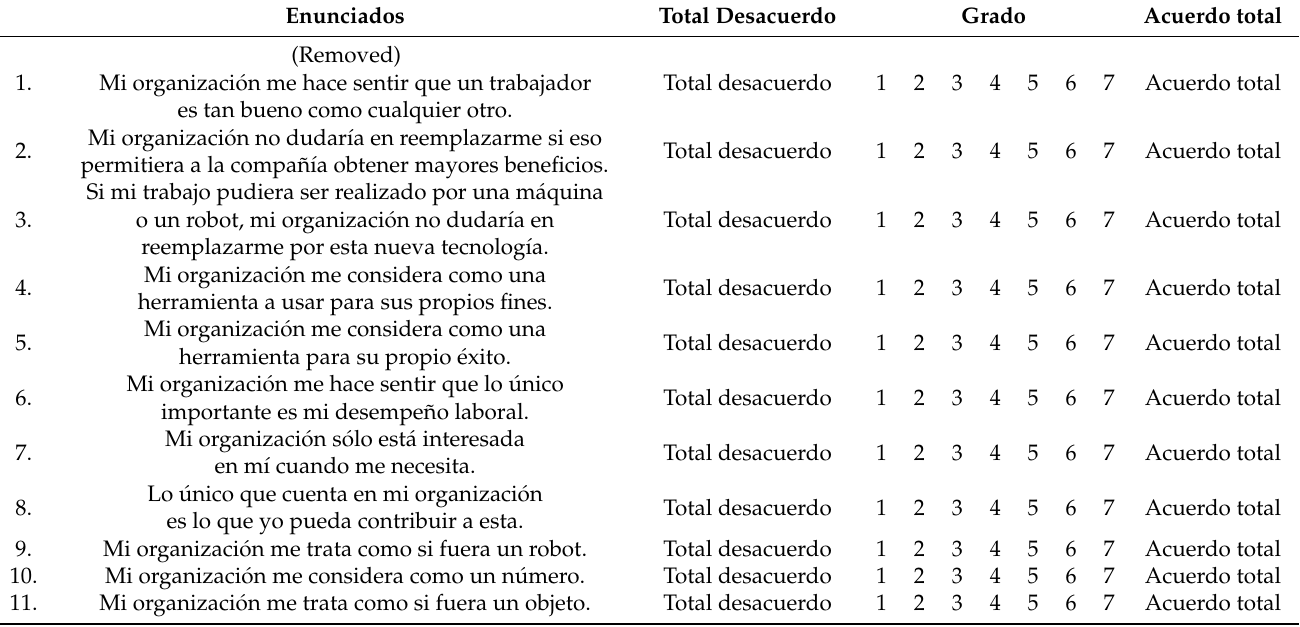
Table A1. Versi ó n en español de la Escala de Deshumanizaci ó n